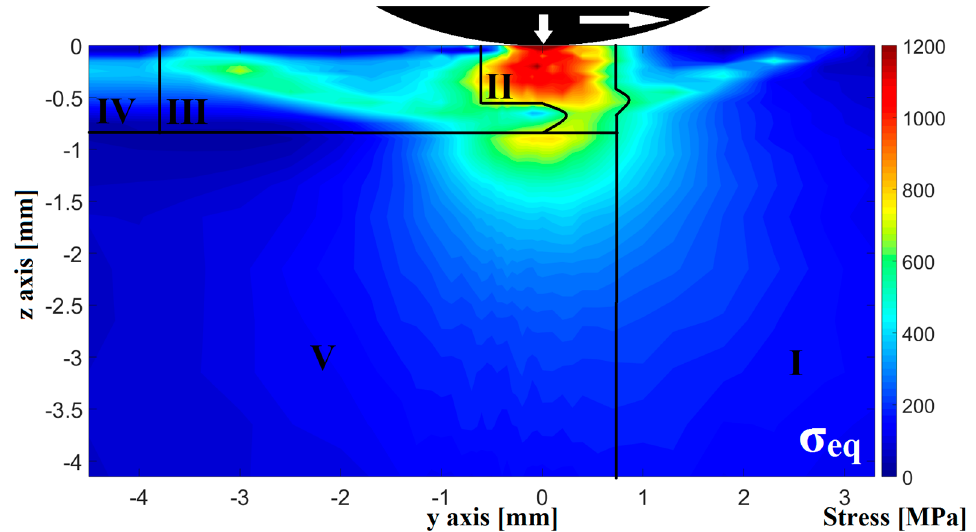
Figure 7. Equivalent stress field σ eq divided into different zones during the deep rolling process with a material load of F = 3900 N.